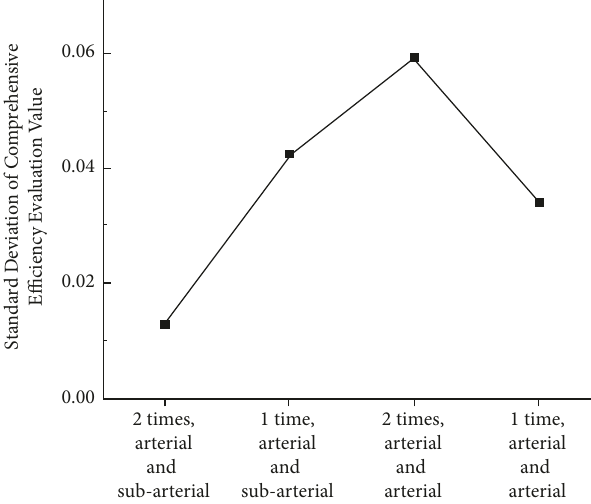
Figure 17: Standard deviation of comprehensive efficiency eval- uation value of different types of